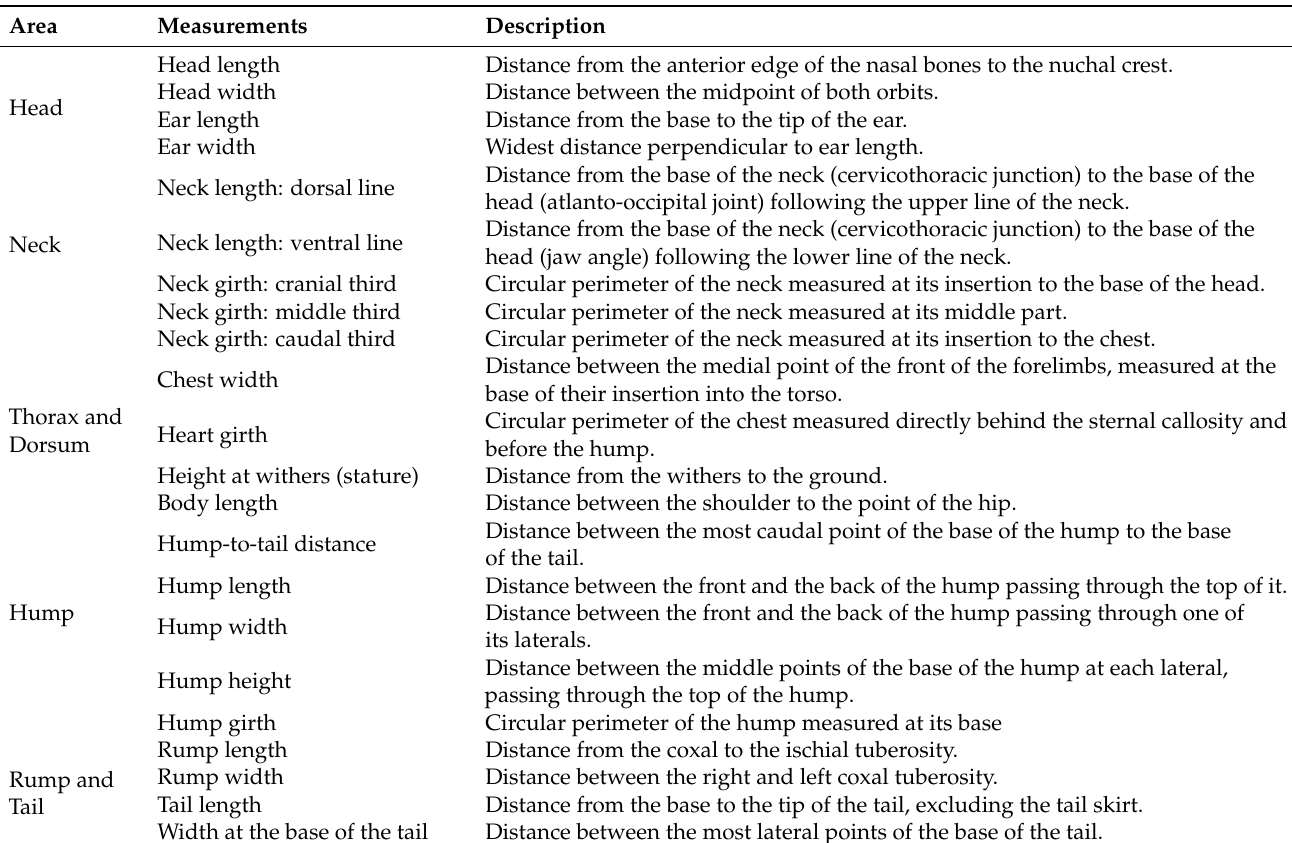
Table 1. Description of the zoometric measures in Canarian camels collected for the